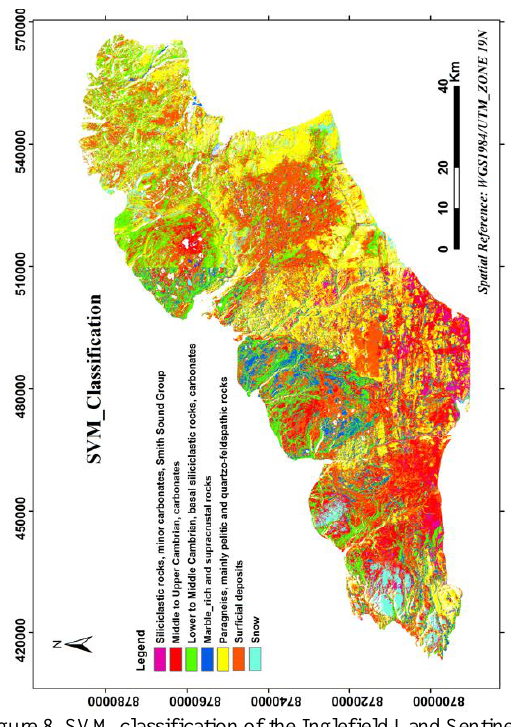
Figure 8. SVM classification of the Inglefield Land Sentinel-2 data.